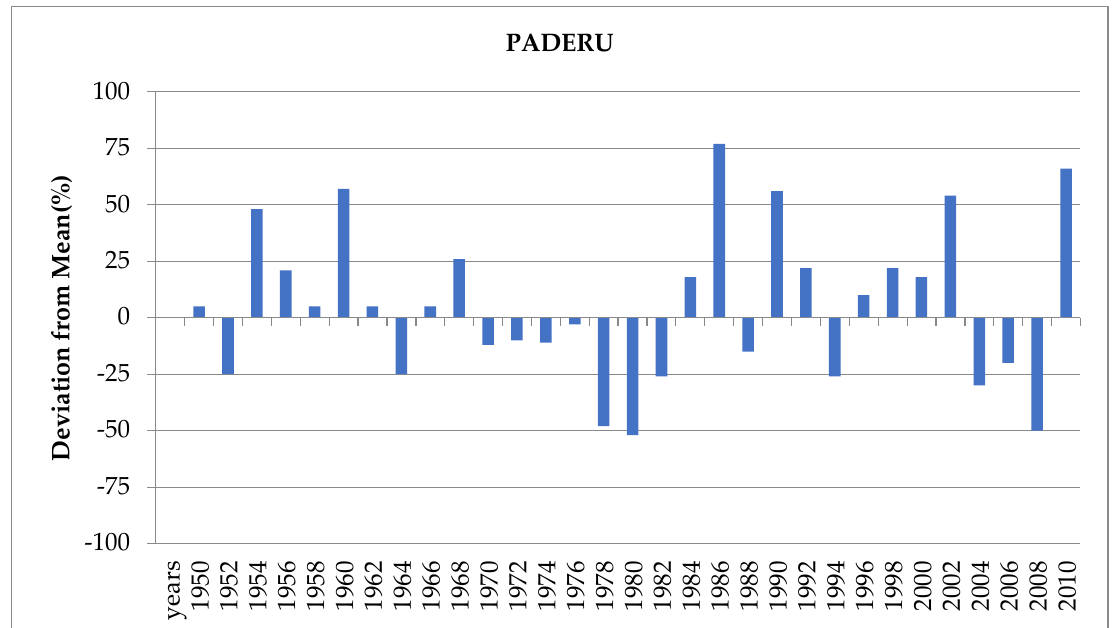
Figure 15. Paderu. Figure 15.